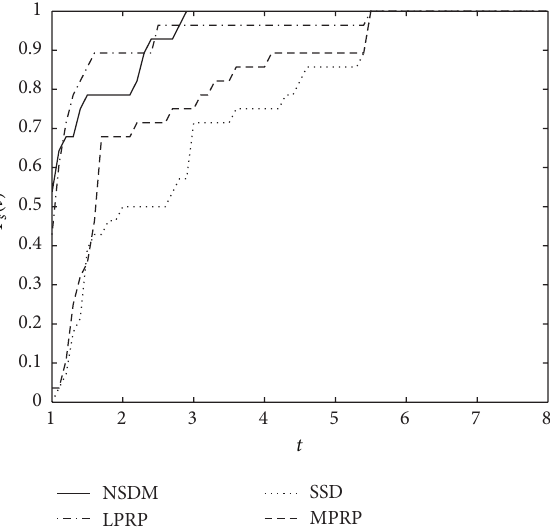
Figure 2: Performance profiles about the number of function eval- uations.